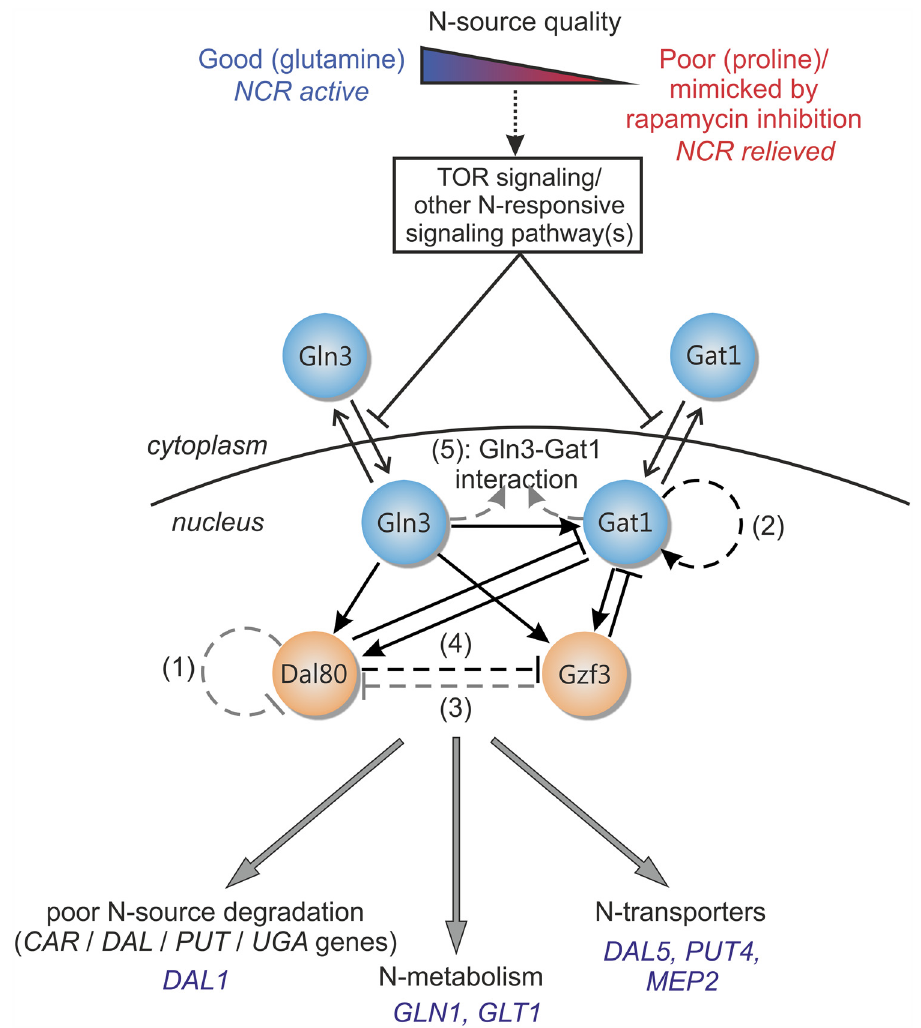
Fig 1. A schematic view of NCR regulation in yeast by the GATA-network. The yeast GATA gene regulatory network responds to the quality of the available nitrogen source and accordingly regulates the transcription of genes related to nitrogen catabolism, a phenomenon termed nitrogen catabolite repression (NCR). Genes subject to NCR are repressed during growth in a good nitrogen source, and derepressed during growth in a poor one, which can be mimicked by rapamycin addition. The signal is mediated via TORC1 and other nitrogen-responsive signaling pathways, thereby determining the nuclear-cytosolic localization of the two GATA activators, Gln3 and Gat1 (blue circles). The two GATA repressors, Dal80 and Gzf3 (orange circles) are only nuclear and active as dimers. The four GATA-factors cross-regulate each other ’ s gene expression extensively. Pointed arrows denote positive transcriptional regulation (gene activation), white T-arrows denote negative transcriptional regulation (gene repression). The established regulatory interactions are represented as solid black arrows. The five hypothesized regulatory interactions compiled from the literature are represented as dashed arrows. Numbers next to dashed arrows denote hypothesis numbers used in model labeling (see Section 1.2 of S1 Text for details). The arrows corresponding to hypothesized interactions contained in the top-ranking model are colored black. GATA- factor controlled genes mainly fall under three functional groups: genes involved in poor nitrogen source degradation, nitrogen metabolism and transport of nitrogen sources. The specific target genes considered in this study are listed in blue under these three